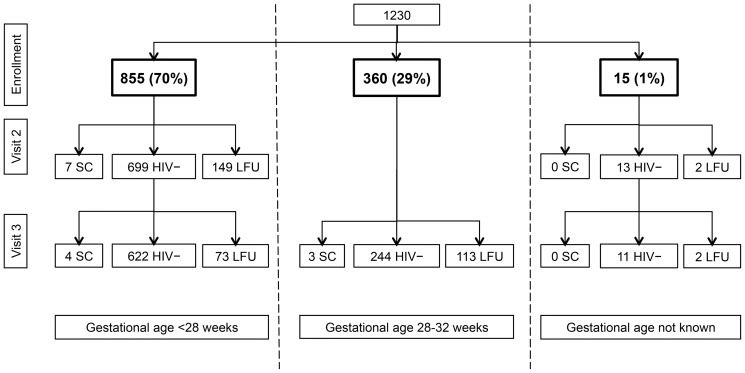
Flowchart of the cohort study.Study visits were scheduled at enrollment, 28 weeks of gestational age (visit 2), and delivery (visit 3). Women enrolled at gestational age <28 weeks (n = 855) had three scheduled visits. Women who enrolled between 28 and 32 weeks of gestational age (n = 360) participated in only two of the three study visits (enrollment visit and delivery). Fifteen women enrolled at a gestational age between 0–32 weeks, but exact age was not known. SC seroconversion; HIV – HIV negative; LFU lost to follow-up.